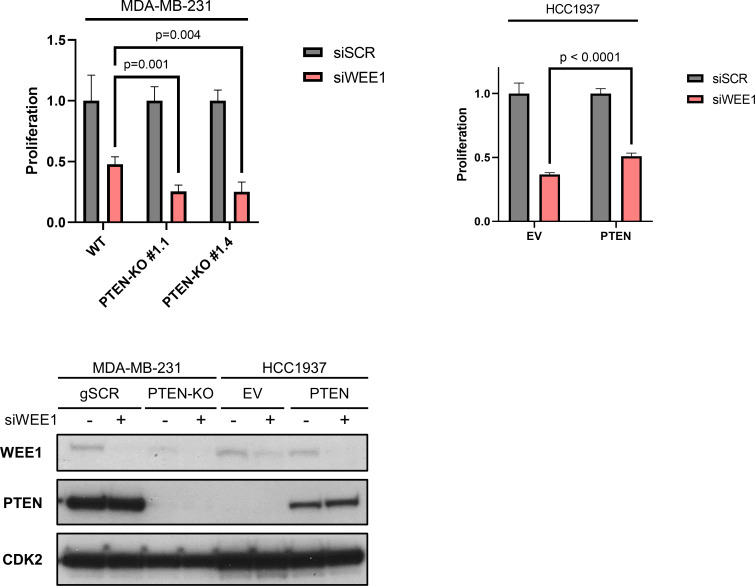
PTEN predicts sensitivity and response to AZD1775 monotherapy.WEE1 was silenced by siRNA transfection in PTEN-proficient and PTEN-deficient cells (MDA-MD-231 (top left) and HCC1937 (top right)) as indicated. Cell viability was analysed by alamarBlue assay. Error bars indicate SD calculated from five replicates. Indicated p-values were assessed by Student’s t-test. WEE1 and PTEN protein expression was analysed by immunoblot analysis and total CDK2 expression used as loading control (bottom panel).